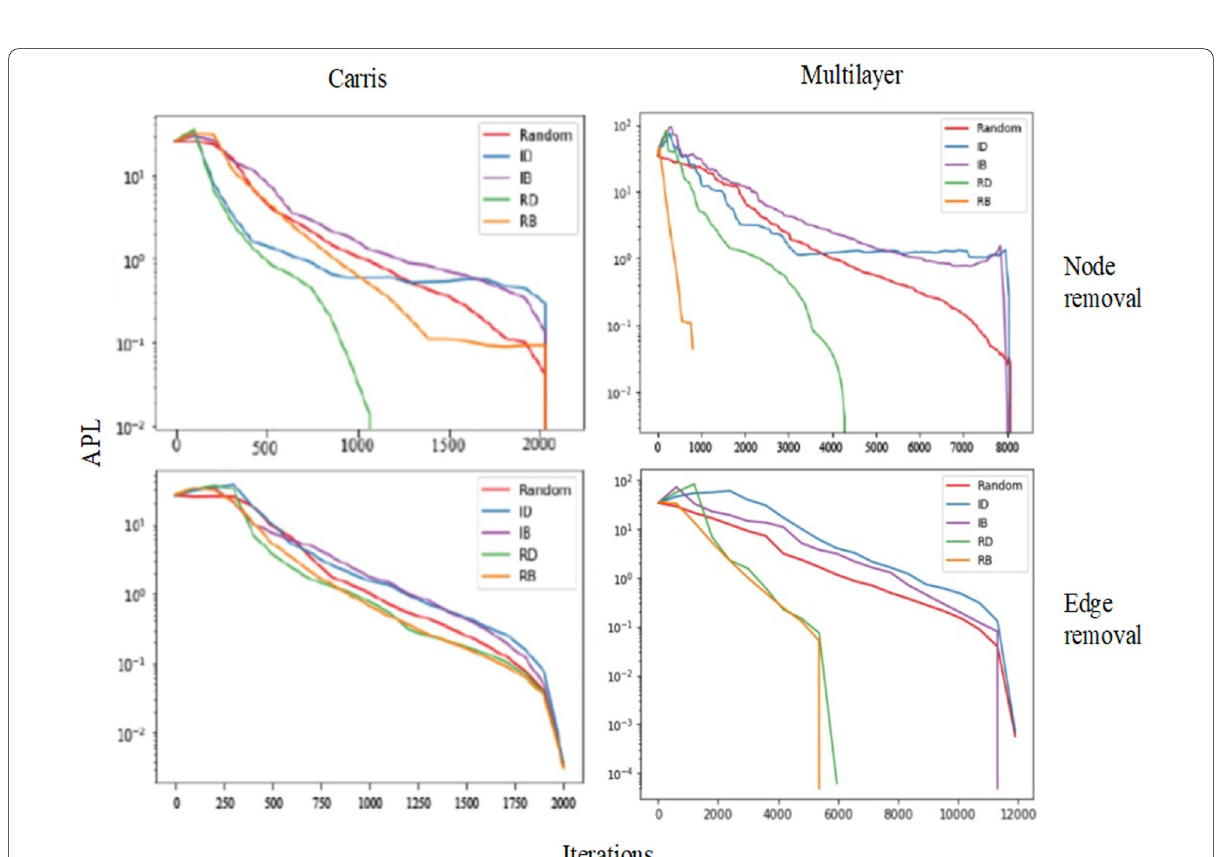
Fig. 11 Evolution of APL along node (above) and edge (bellow) extraction strategies for the CARRIS and the Multilayer